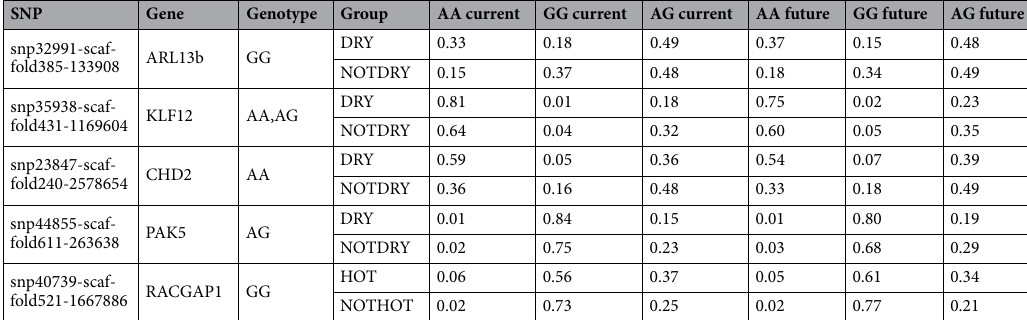
Table 3. Predicted genotypic frequencies for the five polymorphisms recorded within genes identified to be significantly different between the groups HOT/NOTHOT or